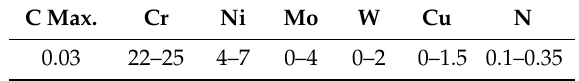
Table 1. Chemical composition of duplex stainless steel (DSS) (%)